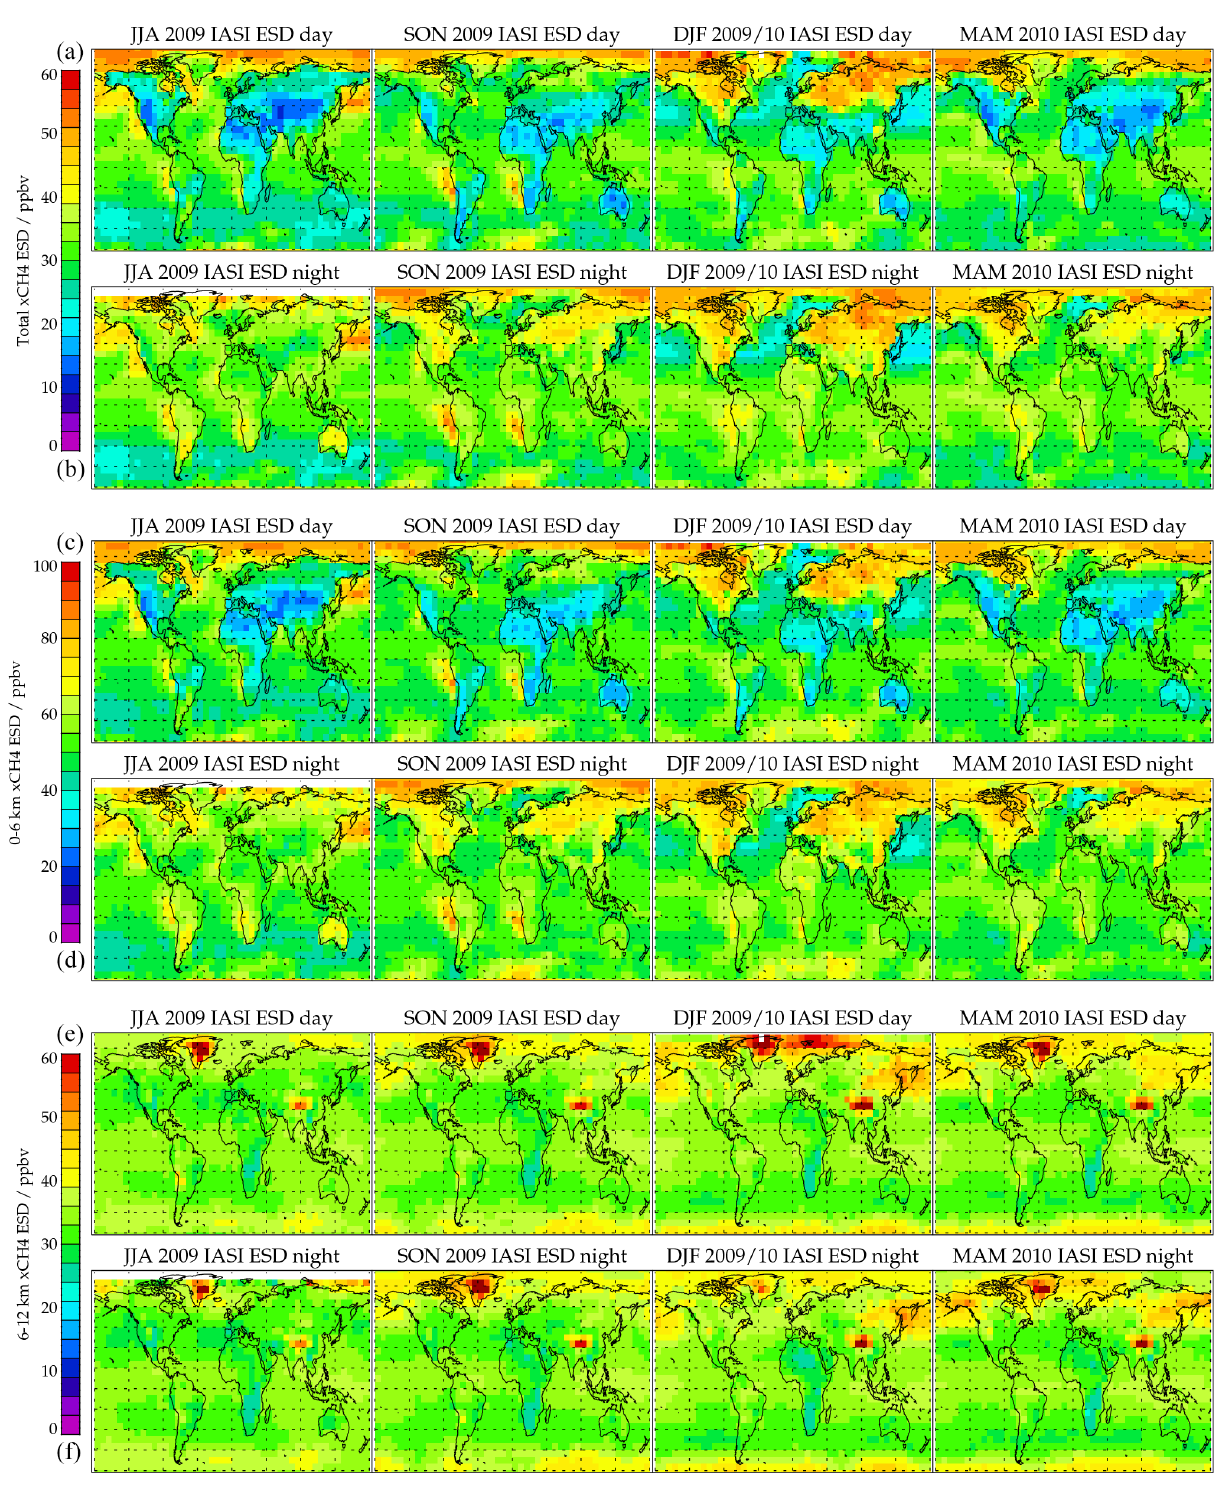
Figure 3. Average in 7 . 5 ◦ × 5 ◦ latitude–longitude bins of the estimated SD (ESD) on column- and layer-averaged mixing ratio as a function of season (left to right) and for day ( a , c and e ) and night-time observing conditions ( b , d and f ). JJA is June, July and August 2009; SON is September, October and November 2009; DJF is December, January and February 2009/10; MAM is March, April and May 2010. Panels ( a and b ) show column-averaged ESD; panels (c–f) show the 0–6 and 6–12km layer-averaged ESDs,